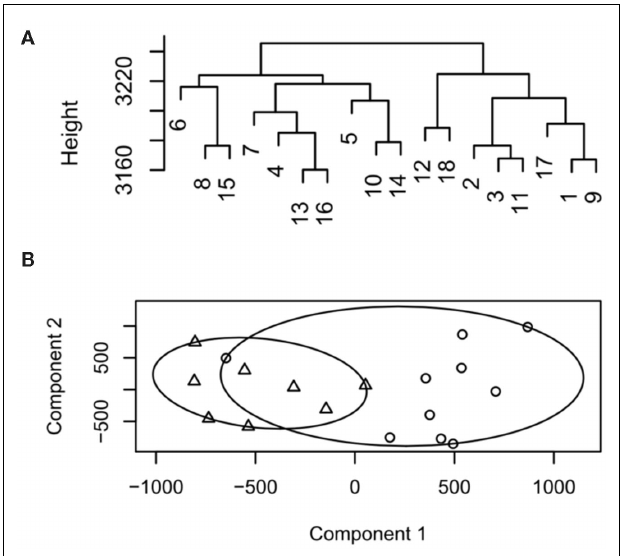
FIGURE 1 | Example dendrogram and cluster plot from low decisive data. (A) Dendrogram, samples 1–9 represent group 1, 10–18 group 2. (B) Cluster plot output for the same data circles represent group 1, triangles group 2.